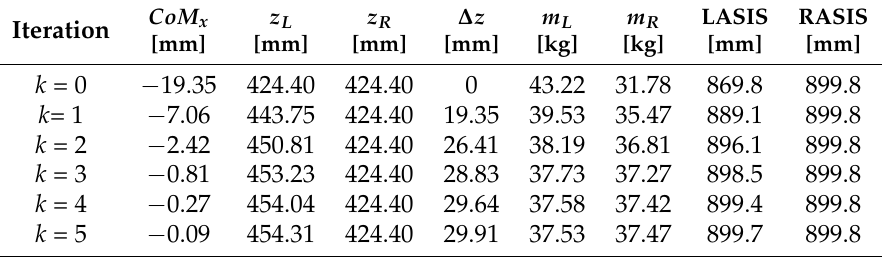
Figure 10. Scenario 1: ( a ) Initial state of the human body with LLD (algorithm iteration k = 0); ( b ) algorithm iteration k = 1; ( c ) algorithm iteration k = 2; ( d ) algorithm iteration k = 3; ( e ) algorithm iteration k = 4; and ( f ) the human body is balanced (algorithm iteration k = 5). Table 1. Scenario 1: Figure 11 response values at the end each iteration of the